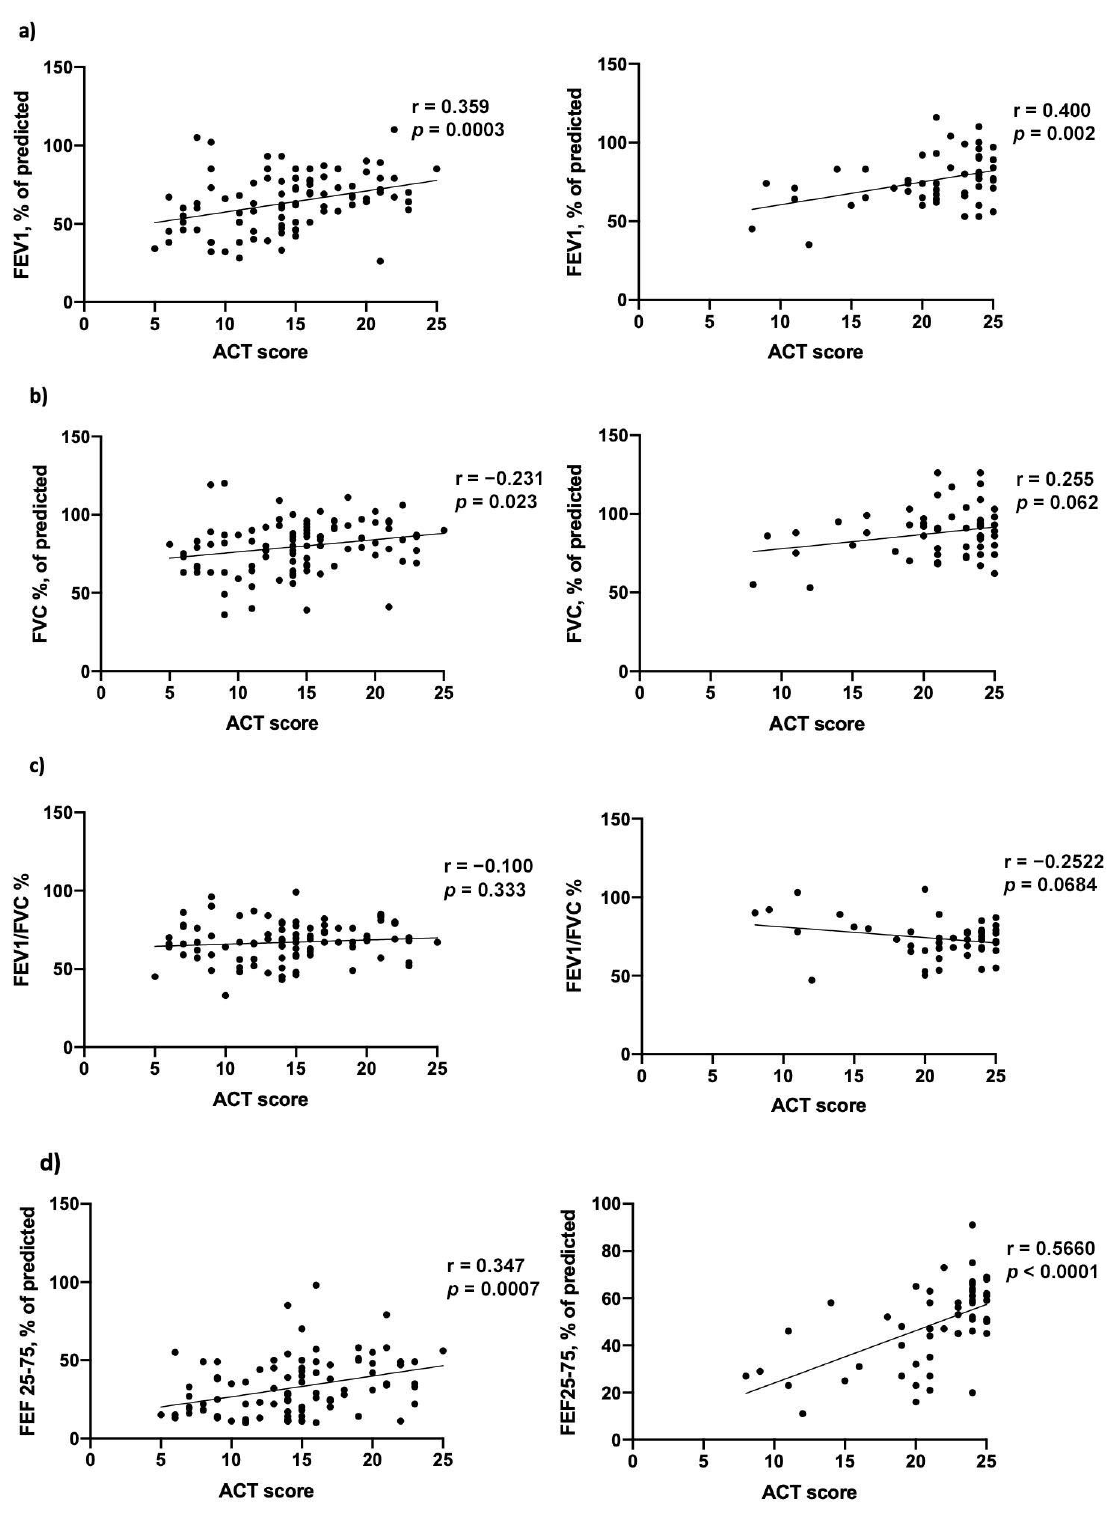
Figure 5. Correlation between Asthma Control Test (ACT) score and pulmonary function tests at baseline ( left ) and after 18 months of mepolizumab treatment ( right ), with regard to ( a ) FEV1% of predicted, ( b ) FVC% of predicted, ( c ) FEV1/FVC% and ( d ) FEF25-75% of predicted.